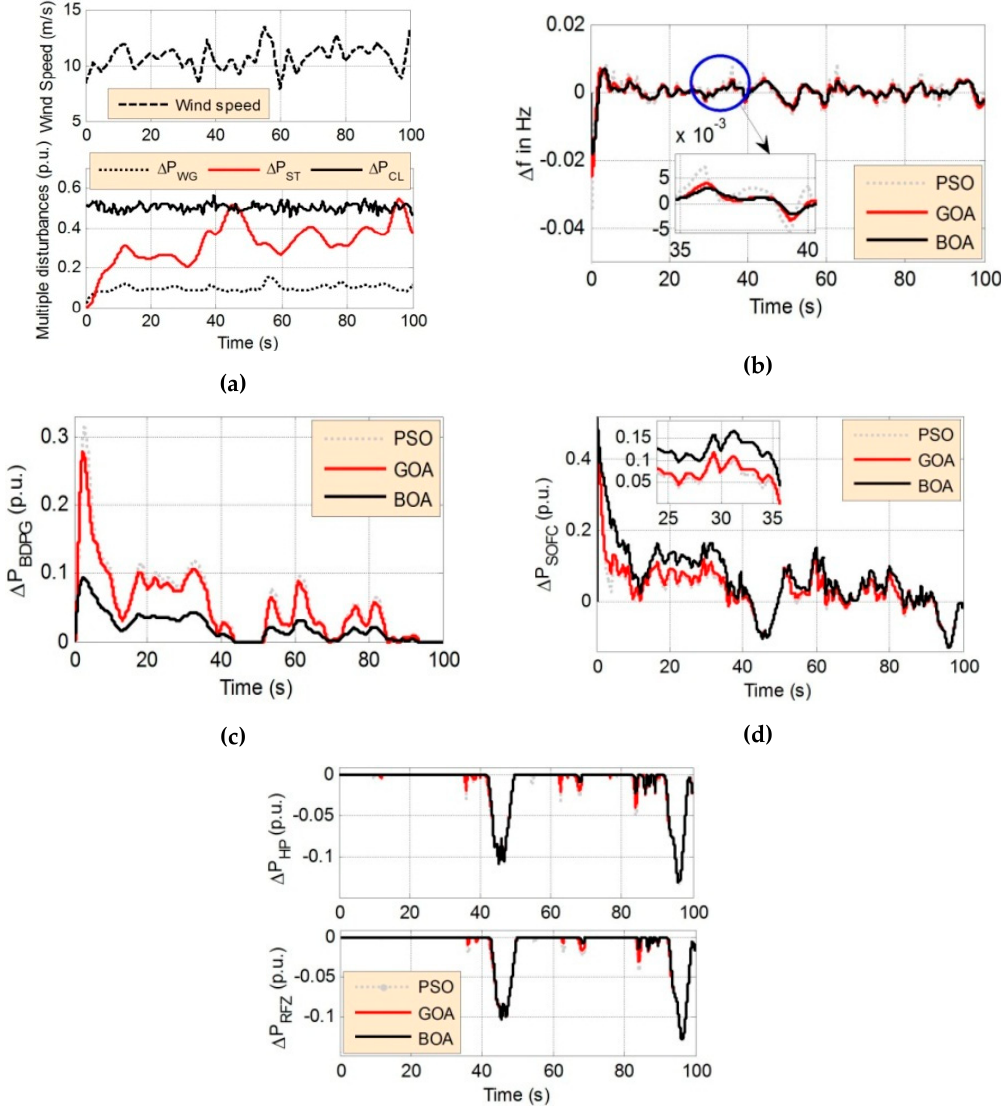
Figure 5. Comparative system dynamics analysis of different algorithmic techniques (PSO, GOA, BOA) ( a ) Real recorded wind speed and other multiple disturbances, ( b ) deviation of system frequency ( Δ f ), ( c ) change in extractable power of BDPG , ( d ) change in extractable power of SOFC , ( e ) change in extractable power of HP and RFZ .